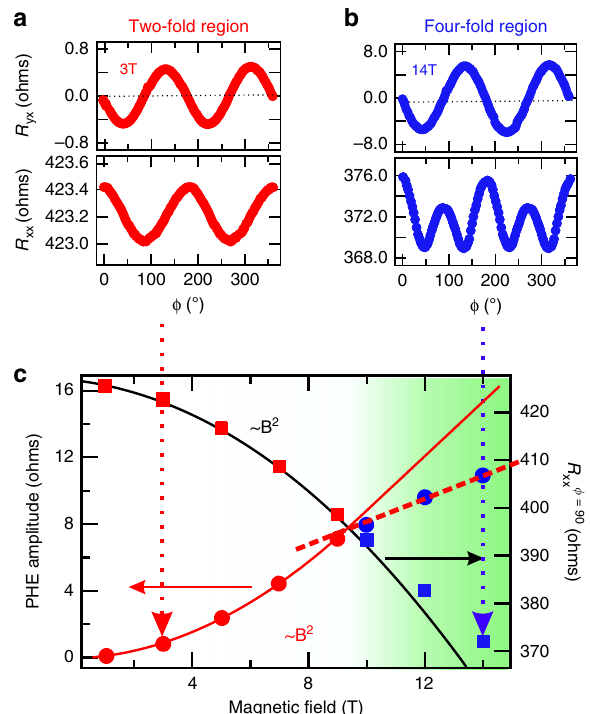
Fig. 5 Signature of ABJ chiral anomaly. (Color online) a R yx and R xx data for 3 T and b for 14 T. c The red markers (white background area) show the low magnetic fi eld region where AMR has two fold symmetry and blue markers (green background) show high- fi eld region where AMR has 4-fold symmetry. Circles represent the PHE amplitude as a function of magnetic fi eld and squares represent R ϕ ¼ 90 (cid:3) i.e. absolute value of magnetoresistance xx R ϕ = 90° as a function of magnetic fi xx for